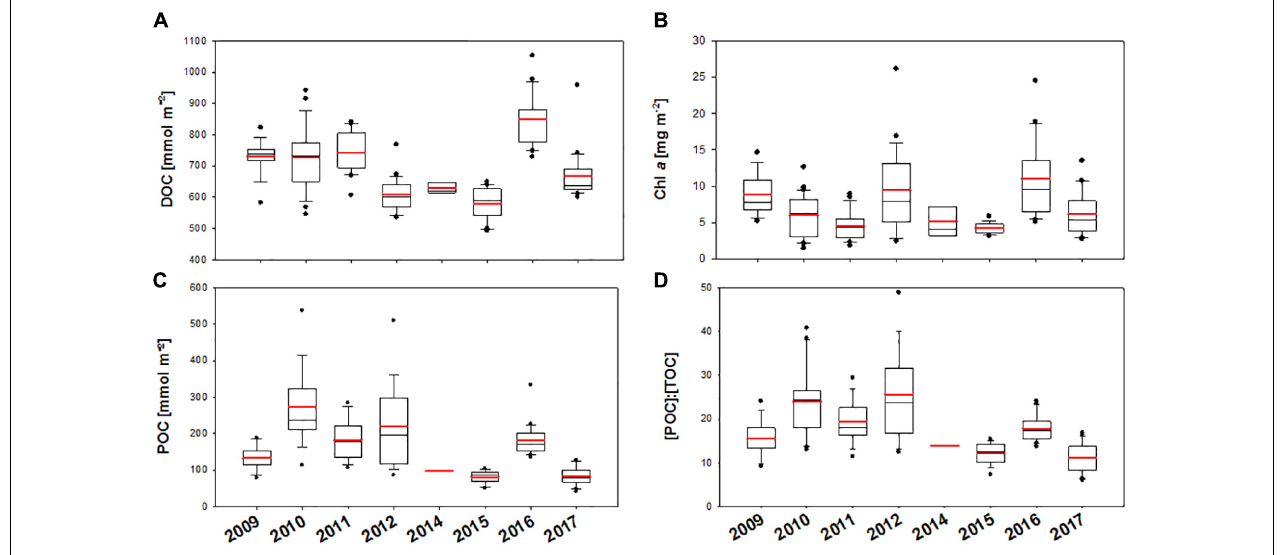
FIGURE 7 | (A–D) Inter-annual variability of integrated (0–100 m) DOC (A) , Chl a (B) , and POC (C) concentration as well as the percentage of POC in TOC (D) in the HAUSGARTEN area from 2009–2017. Box plots show 25–75 th percentile of data within the box, error bars 10th and 90 th percentile, outlying data as well as the mean (red line) and median values.